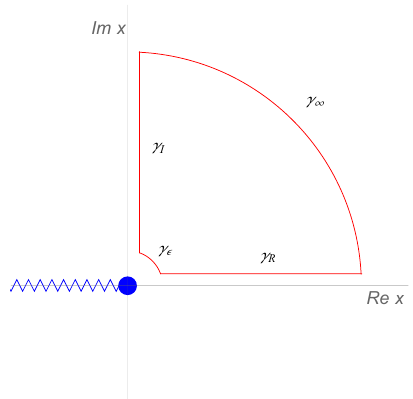
Figure 4. Integration contour γ in the complex plane. The outer circumference has radius | x | → ∞ , while the inner one is described by the curve x = (cid:15) e iθ , with 0 < θ < π/ 2 . The branch cut is shown in